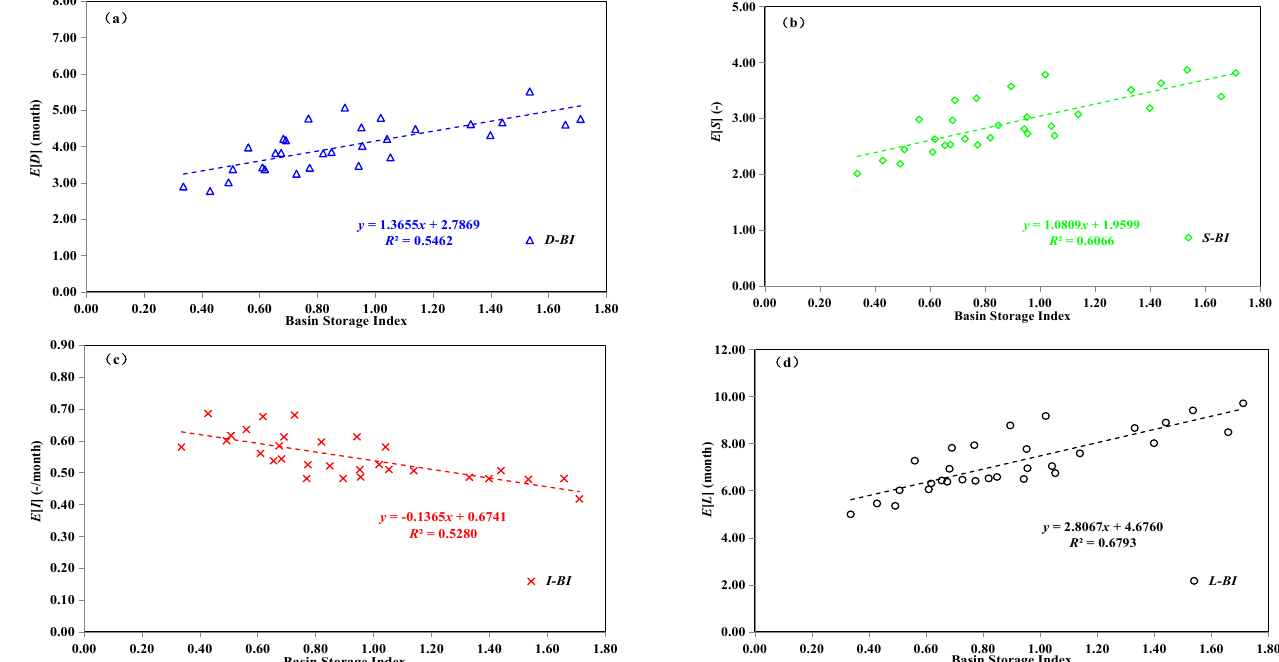
Figure 6. Correlation between Basin Storage Index and ( a ) E [ D ]; ( b ) E [ S ]; ( c ) E [ I ]; ( d ) E [ L ].